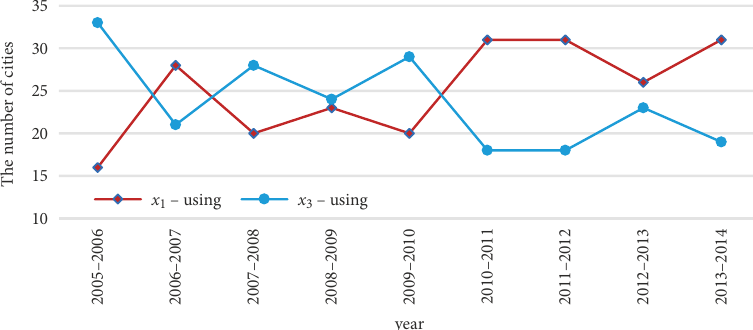
Figure 3. Input biased technological changes of capital stock ( x 1 ) and electricity consumption ( x 3 )